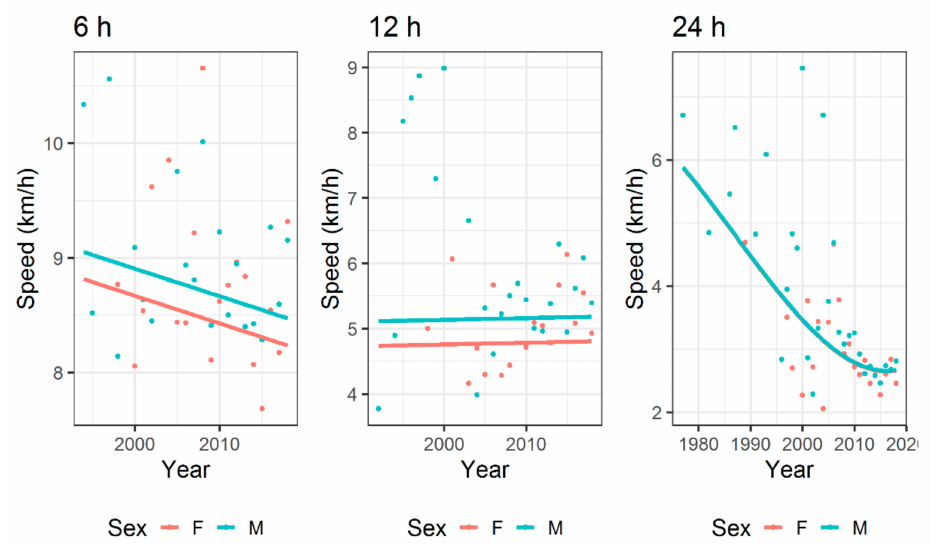
Figure 4. Running speed across years for time-limited ultra-endurance events for 6, 12 and 24 h. Fitted values = line, points = observed mean